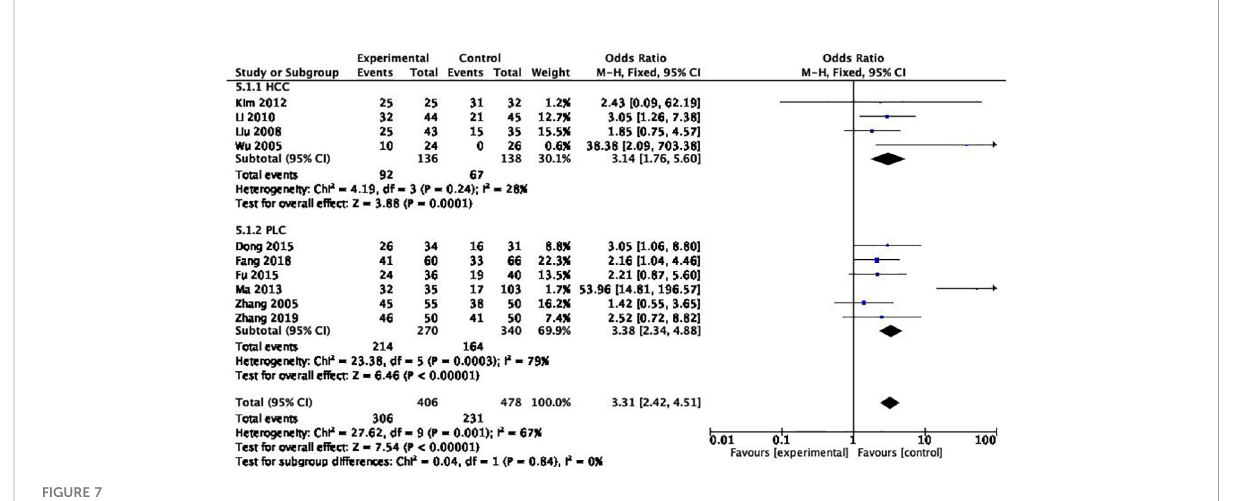
FIGURE 7 Subgroup analysis of restricted pathologic types.